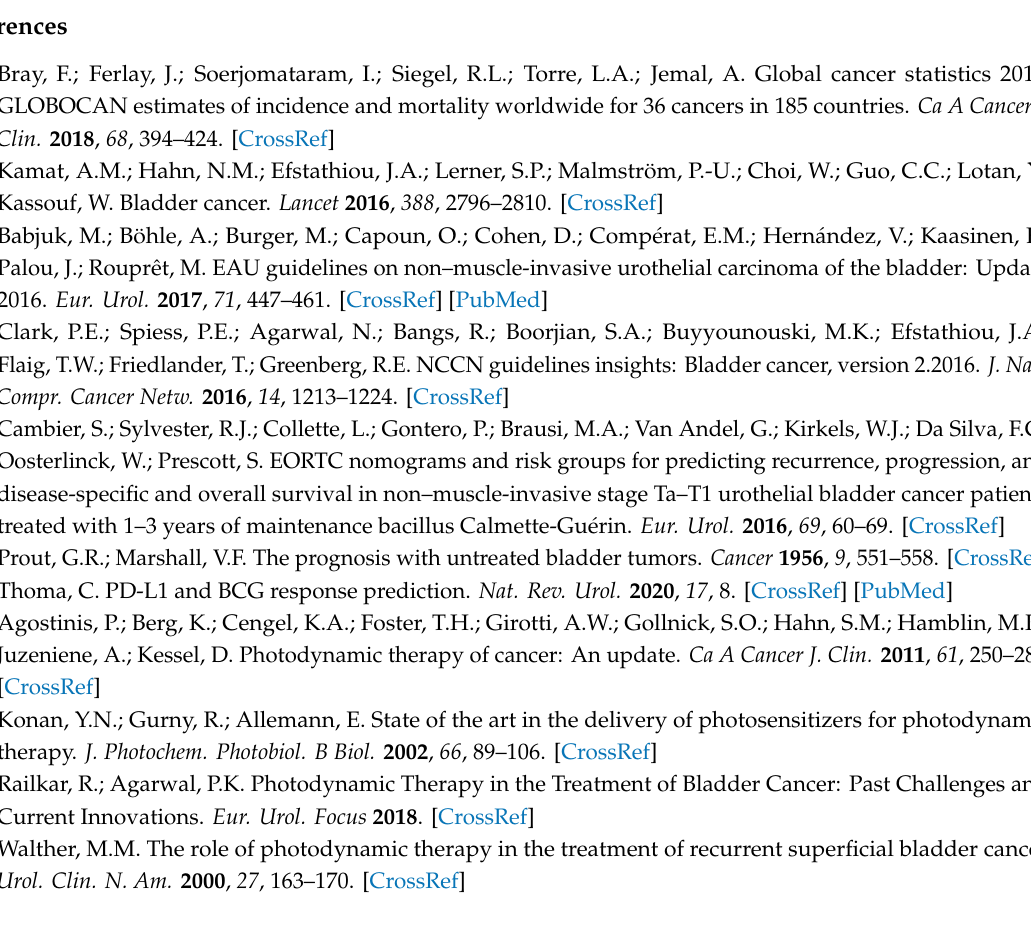
Figure S1: Size distribution measurements of (a) Au@TNA NPs and (b) Au@TNA@MB NPs on the basis of TEM image measurements; Figure S2: UV-visible spectra of the MB alone and the 1st / 3rd supernatant solution collected from the mixture solution of Au@TNA nanoparticle and MB molecule through a centrifugation process; Figure S3: UV-visible measurements of (a) Au@TNA NPs and (b) Au@TNA@MB NPs aged in PBS solution. Optical images of (c) Au@TNA NPs and (d) Au@TNA@MB NPs dispersed in PBS solution for 30 min; Figure S4: (a) UV-visible and (b) fluorescence measurements of the MB alone solution, referred as 100 % of concentration, and the supernatant of the Au@TNA@MB nanoparticles after 1 day of aging; Figure S5: Uv-visible spectra of ABDA reacted with 200 µ L of (a) Au@TNA@MB nanoparticles (200 ppm[Au]) and (b) MB alone solution (0.024 mM) under an excitation at 650 nm. The absorption changes at 400 nm of MB alone, Au@TNA NPs, and Au@TNA@MB NPs under an excitation at 650 nm; Figure S6: UV-visible spectra of the RNO / imidazole indicator for measuring single oxygen generation from MB-alone solution as a function of the irradiation time at 650 nm (125 mW / cm 2 ); Figure S7: (a) TEM image and (b) UV-visible spectrum of FA-conjugated Au@TNA@MB NPs. (c) Zeta potential measurements of Au@TNA, Au@TNA@MB, and FA-conjugated Au@TNA@MB